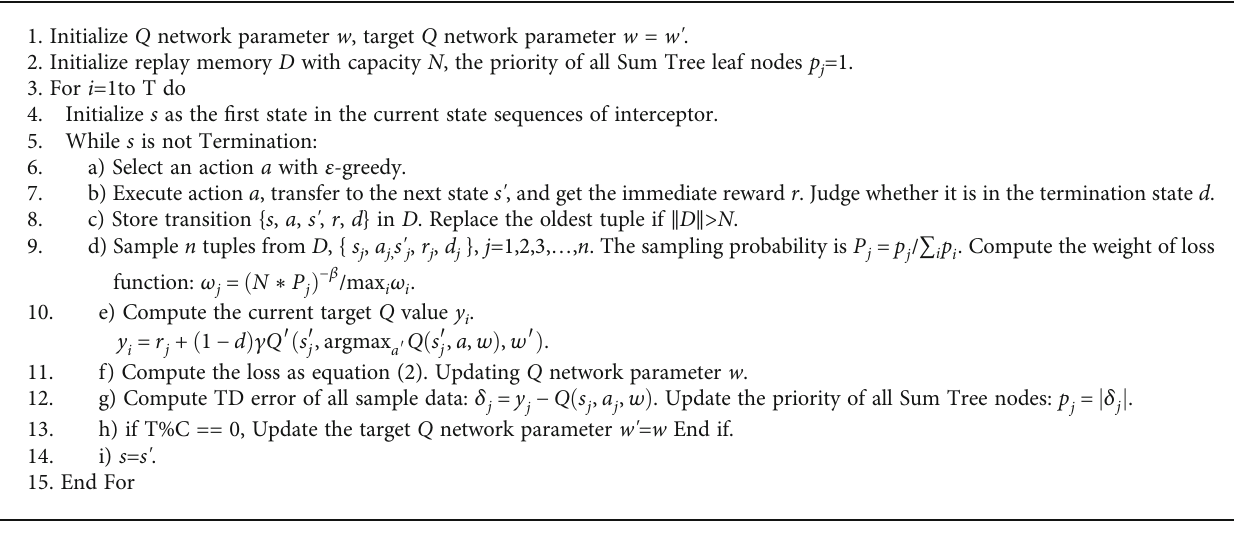
Algorithm 1: Prioritized experience replay DQN for homing guidance.